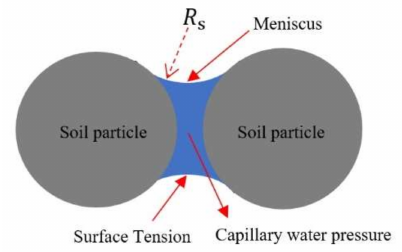
Figure 10. Schematic diagram of soil particle interaction in unsaturated